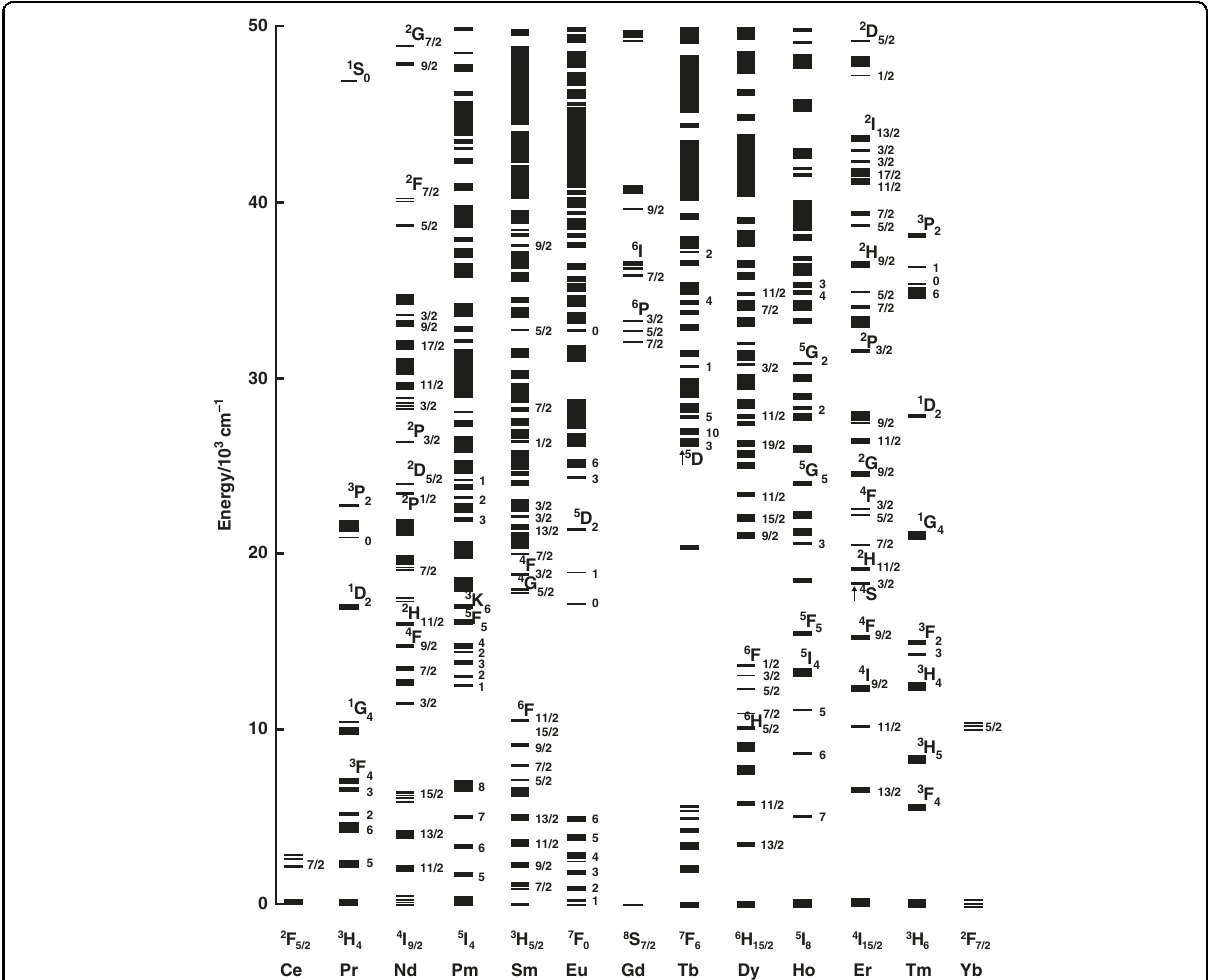
Fig. 1 Partial energy levels diagram of RE ions doped in a low-symmetry crystal (LaF3). Reprinted from [3], with the permission of AIP commercial fi eld should pro fi t from the huge boosts of device ef fi ciency and stability. For example, the lifetime of OLEDs at typical brightness levels far surpasses the average lifetime of state-of-the-art mobile phones. Fur- thermore, the electric-photo conversion ef fi ciency of OLEDs has closed to the theoretical limit by utilizing light extraction technology. Despite enormous progresses of OLEDs technology have been made, there are still inex- tricable issues that impede the further development of OLEDs 15 – 17 . One challenge is realizing high ef fi ciency at high brightness level: the difference in carriers ’ mobility may reduce carriers recombination probability within emissive layer (EML), thus resulting in low excitons yield. Meanwhile, excess carriers will cause exciton-polar quenching. In addition, due to unbalanced distribution, carriers ’ recombination zone is generally very narrow. With increasing current density, exciton density increases